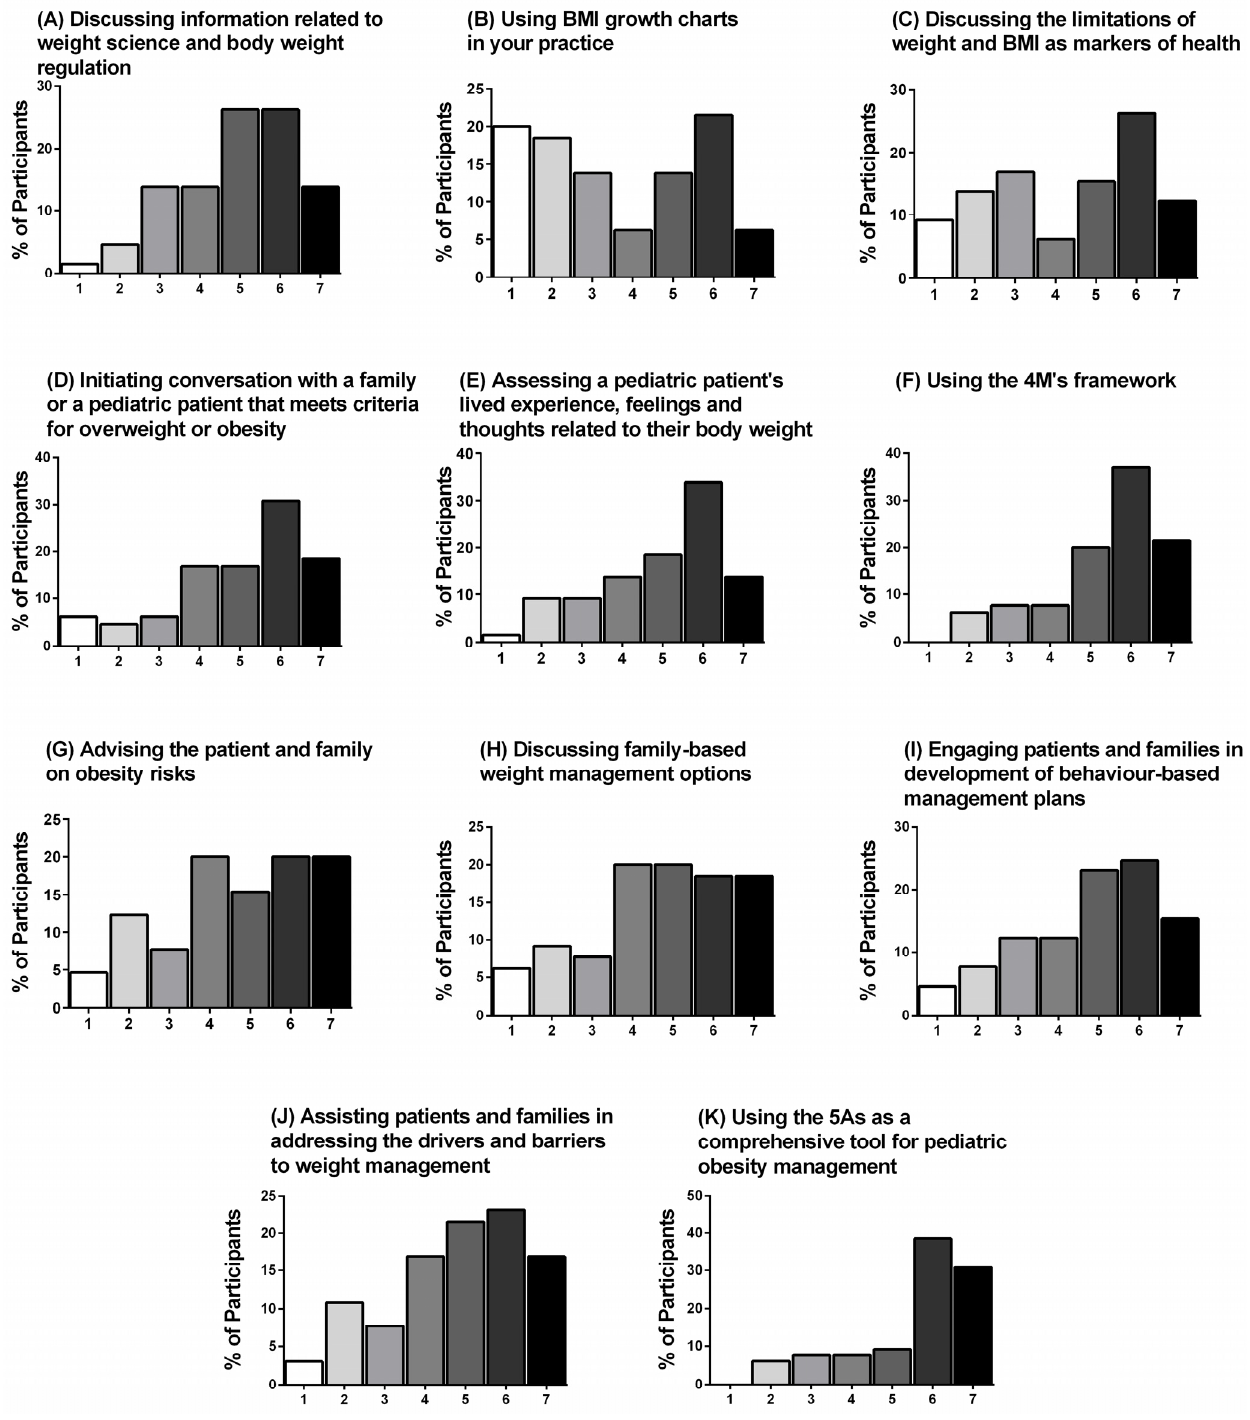
Figure 3. ( A – K ) Post-video change in self-efficacy. Participant agreement (%) measured using a Likert-type scale (1 to 7, where 1 = No change (or reduction in self-efficacy), 2 = Almost the same, 3 = A little better, 4 = Somewhat better, 5 = Moderately better, 6 = Better, and 7 = A great deal better) is shown for each statement ( n = 65).